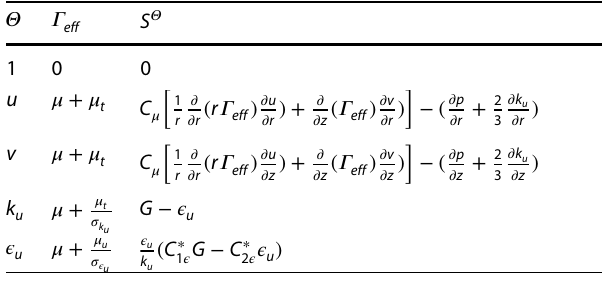
Table 1 The source terms ( S 𝛩 ) for generalized Eq. (1) for PANS k